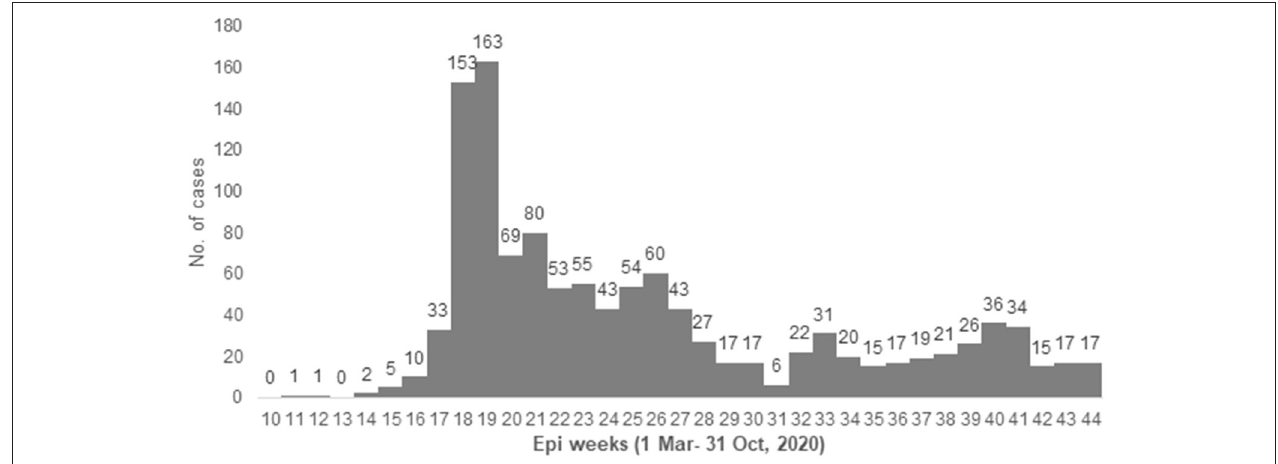
FIGURE 1 | Epidemic curve with case number of HCWs with COVID-19 in PHCC from 1 March to 31 October 2020 (Epiweeks